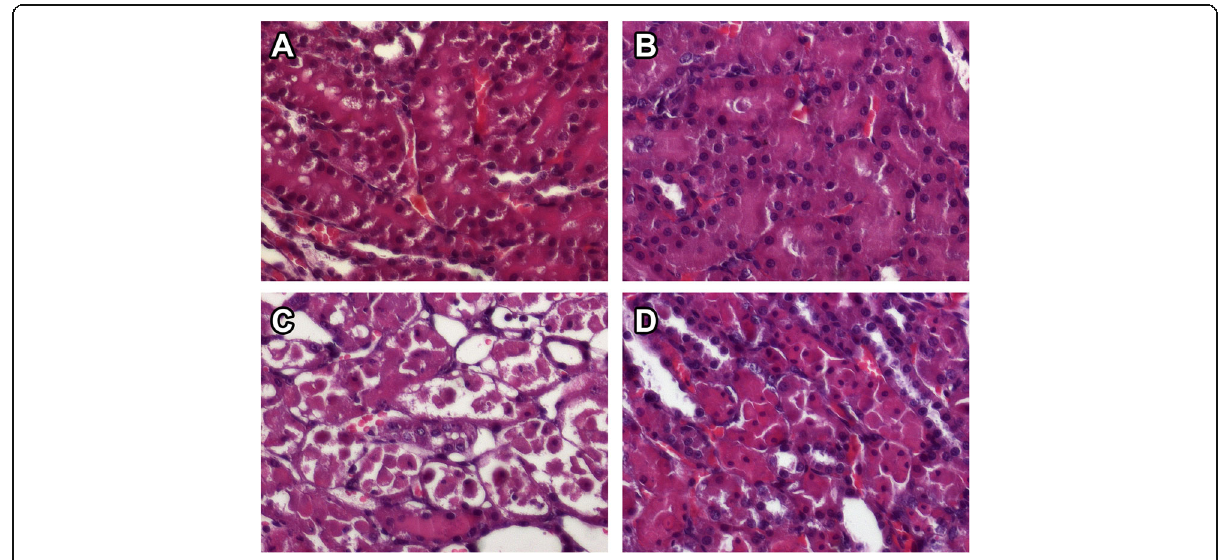
Table 2 Histopathological changes in all studied groups Experimental group